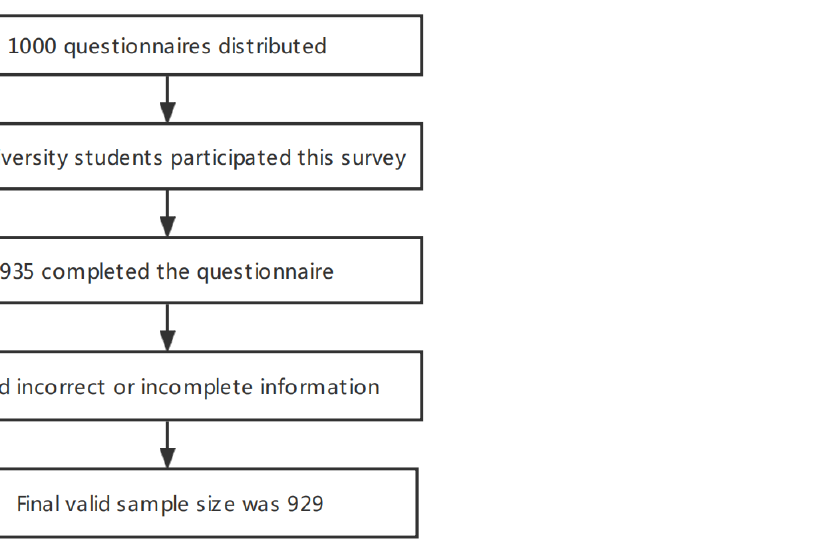
Figure 1. Participants enrolled according to inclusion and exclusion criteria and questionnaire com- pletion.